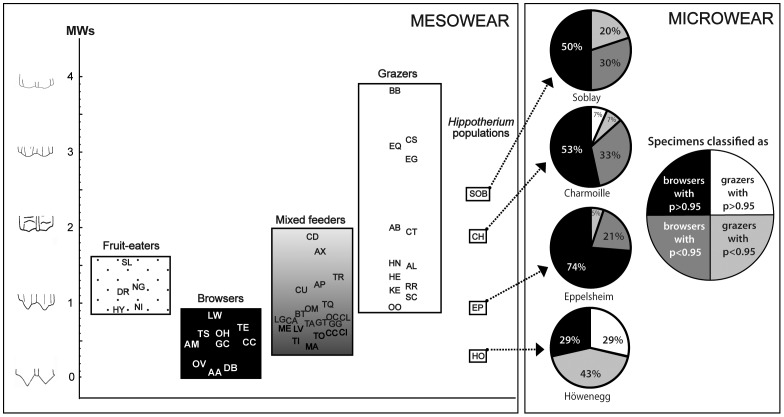
Molar mesowear and microwear patterns of the four populations of Hippotherium primigenium.Comparative extant species for microwear analysis are shown in Table S4 and in Table S5 for mesowear scoring.